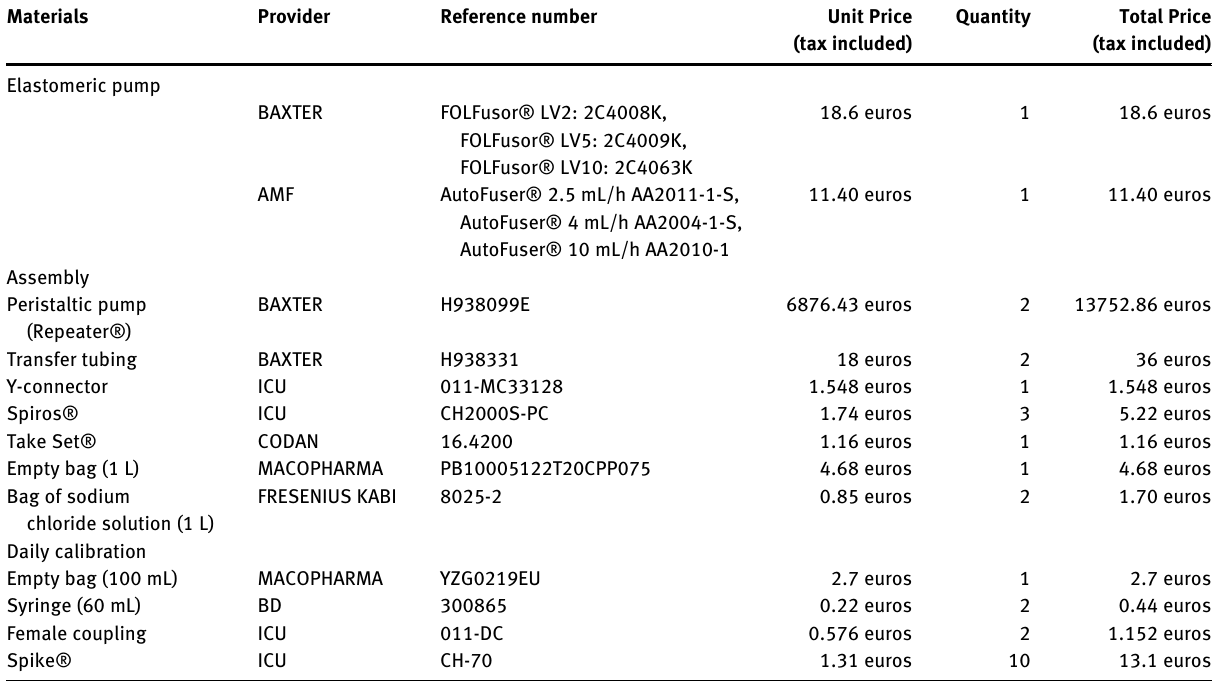
Table  : Materials used for automated preparation of elastomeric pump.